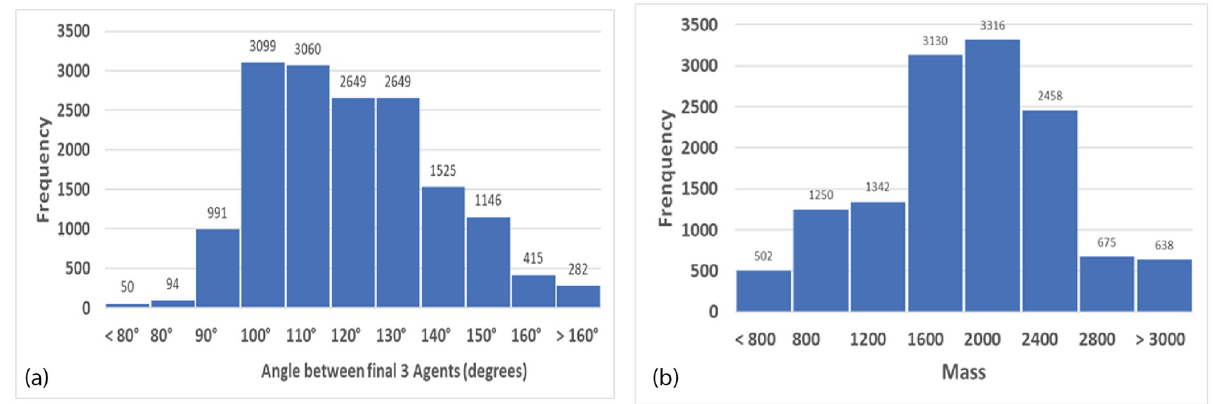
Fig 15. Histograms of angle and mass for final states with three agents: a) Angle between adjacent agents. Mean = 120˚, SD = 17.5˚. b) Mass of final agents. Mean = 2000, SD = 653 3 final agents.